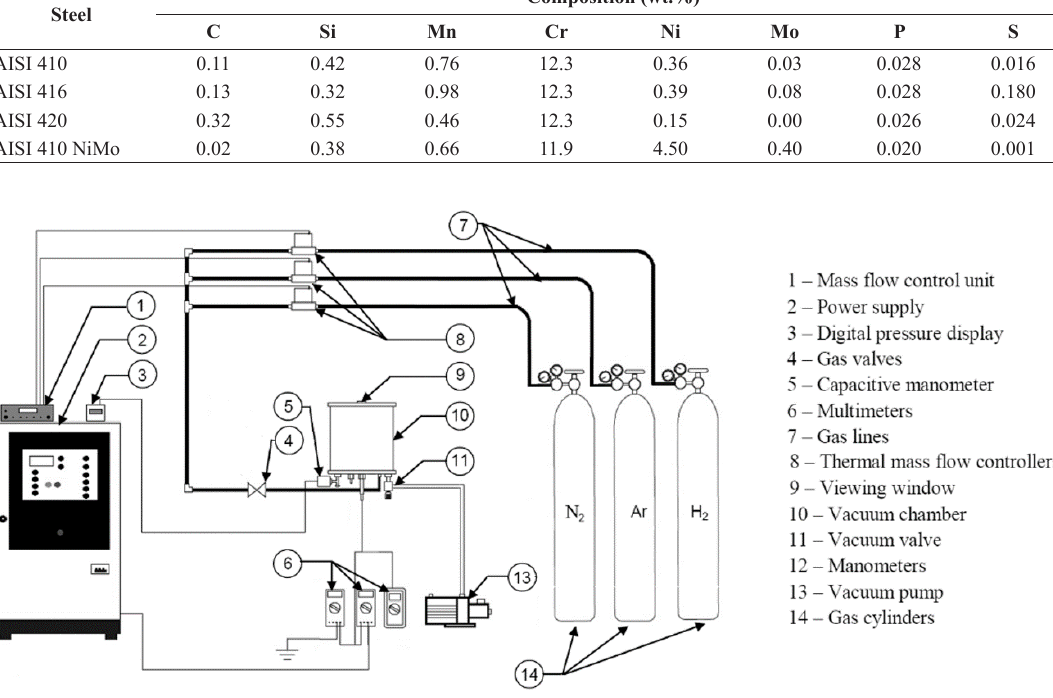
Figure 1. Scheme of the low-temperature plasma nitriding experimental